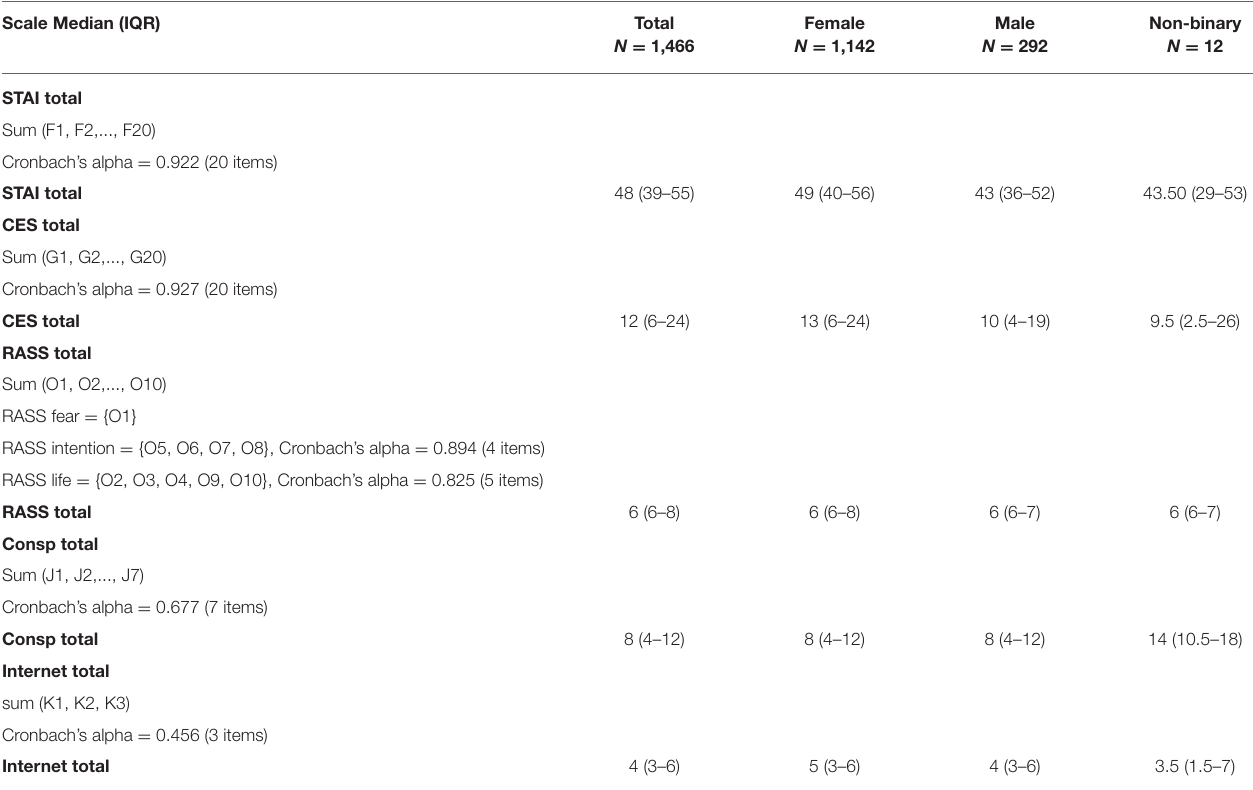
TABLE 3 | Descriptive statistics and internal consistency of scale scorings for STAI, CES, RASS, belief in conspiracy theories, and internet use. Scale Median (IQR) Total